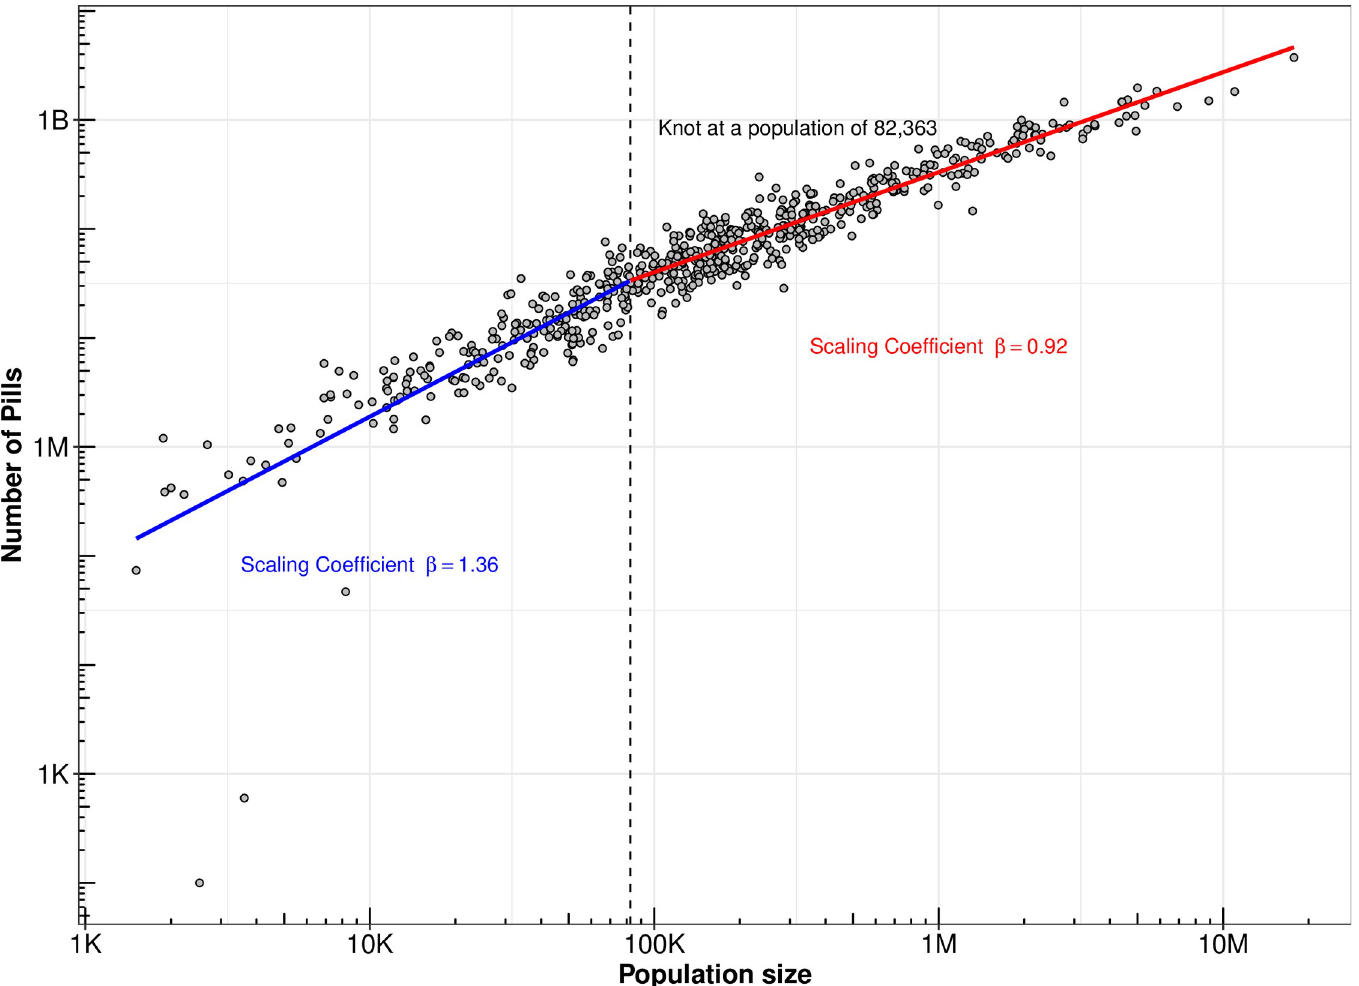
Fig 1. Non − linear scaling of pill sales including all 607 CZs: Piecewise regression with a spline at a population of 82,363. Footnote: β is the coefficient of the regression log(pills) on log(population). Sources: ARCOS and Census Bureau.